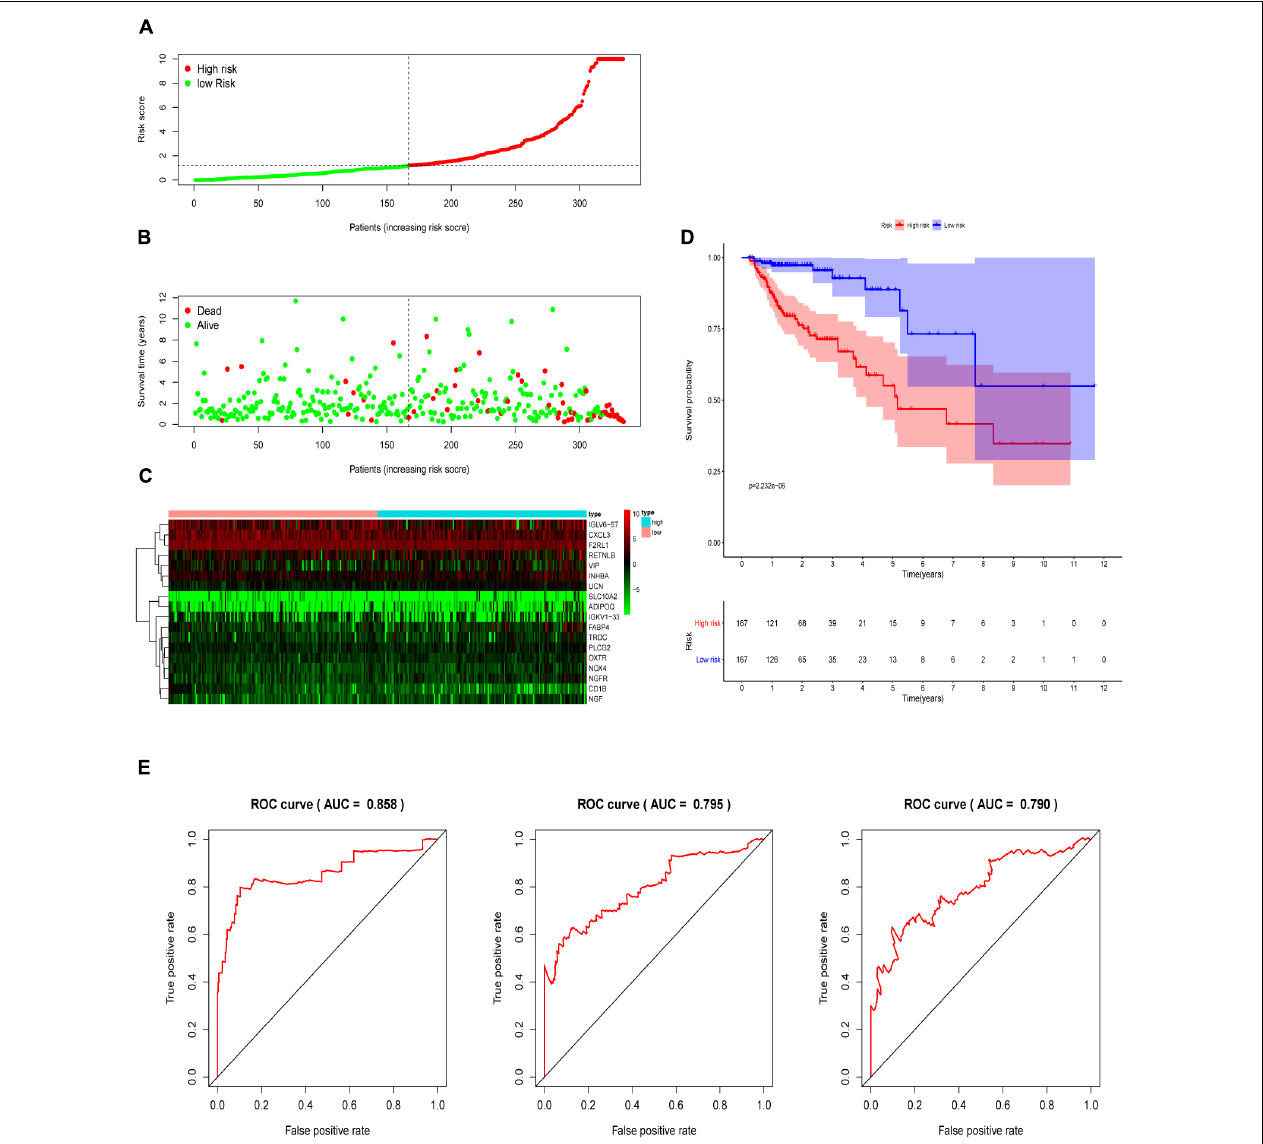
FIGURE 5 | Construction of an immune-related prognostic signature for CRC. (A) The risk score distribution of CRC patients in The Cancer Genome Atlas (TCGA) database. (B) Survival status and duration of patients. (C) Heatmap of the expression of 18 immune-related genes in CRC patients. (D) Survival curves for the low-risk and high-risk groups. (E) The receiver operating characteristic curve (ROC) analysis predicted overall survival using the risk score. The forecast time is 1, 3, and 5 years.